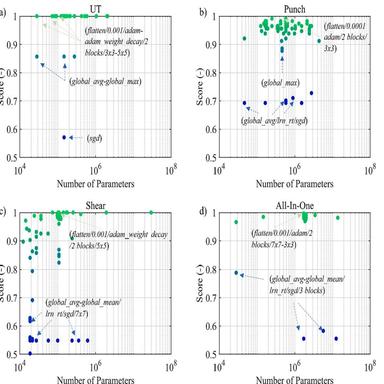
Validation scores of different vanilla CNN network-based architectures identified by a greedy-search algorithm for the UT (a), Punch (b) and shear loading (c) material tests. The corresponding scores for the All-In One case are provided in (d).